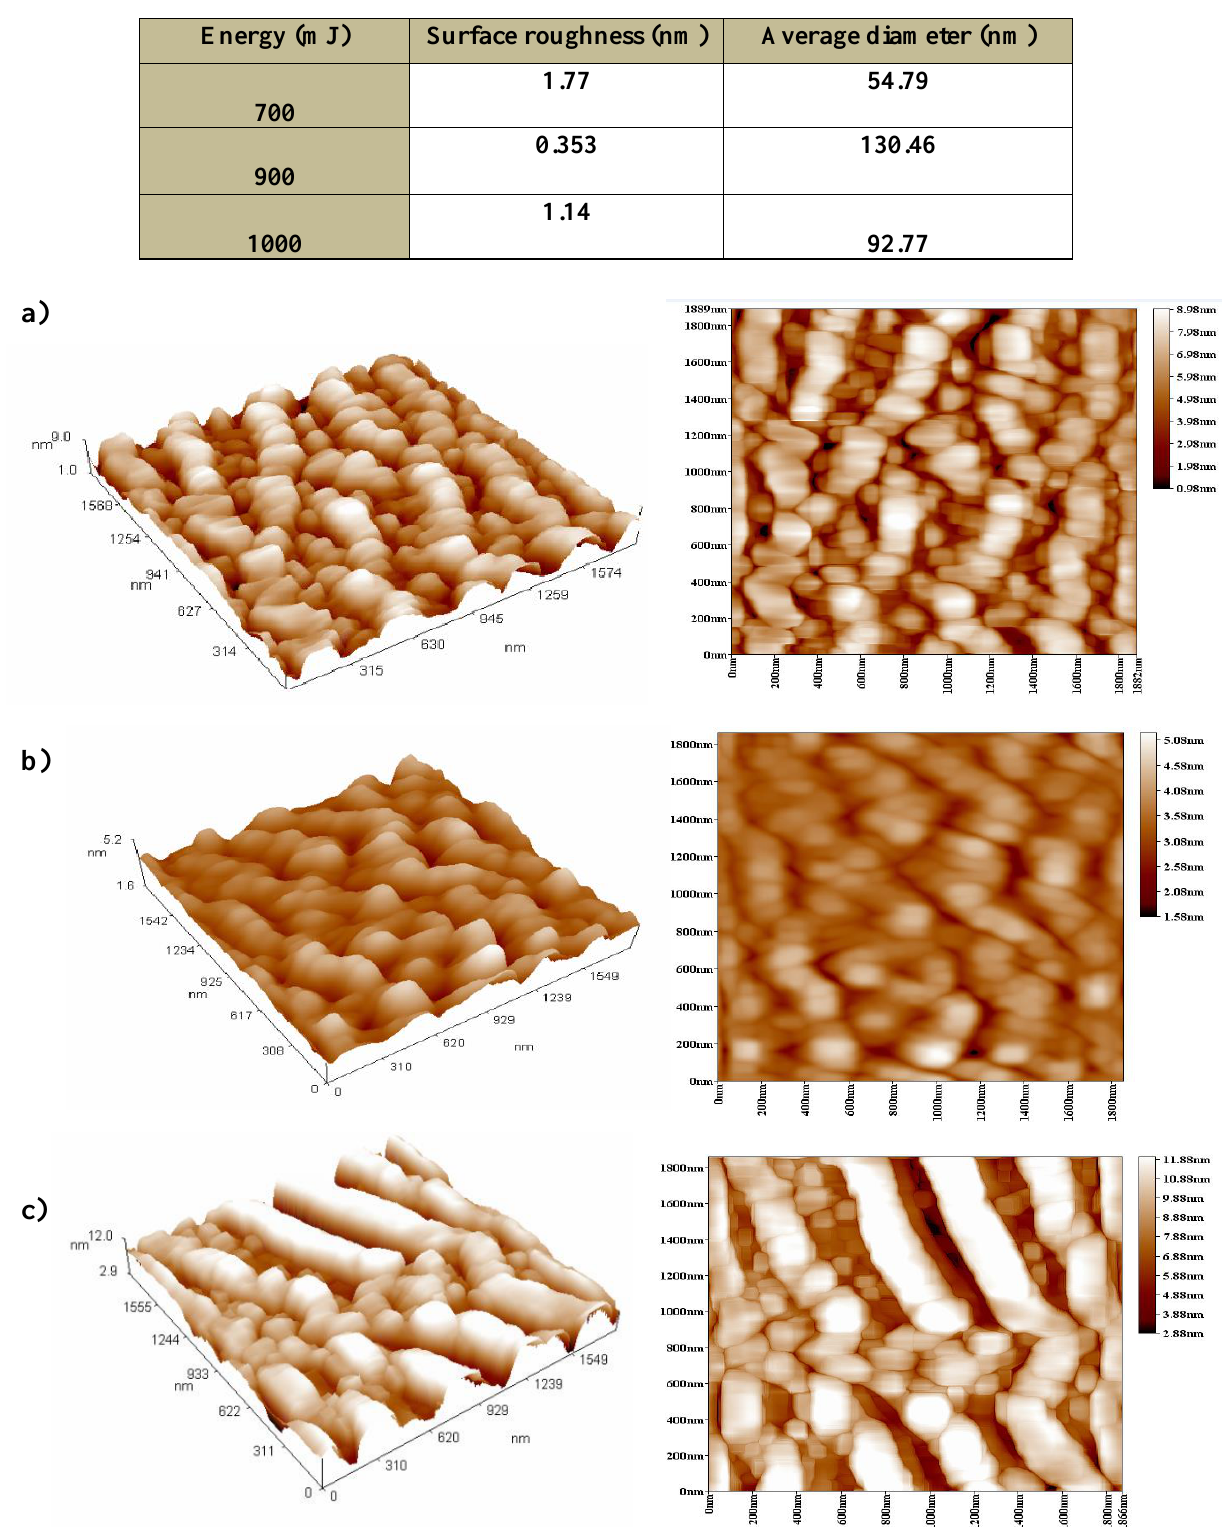
Fig.8: AFM images at a) 1000mJ, b) 900mJ and c)